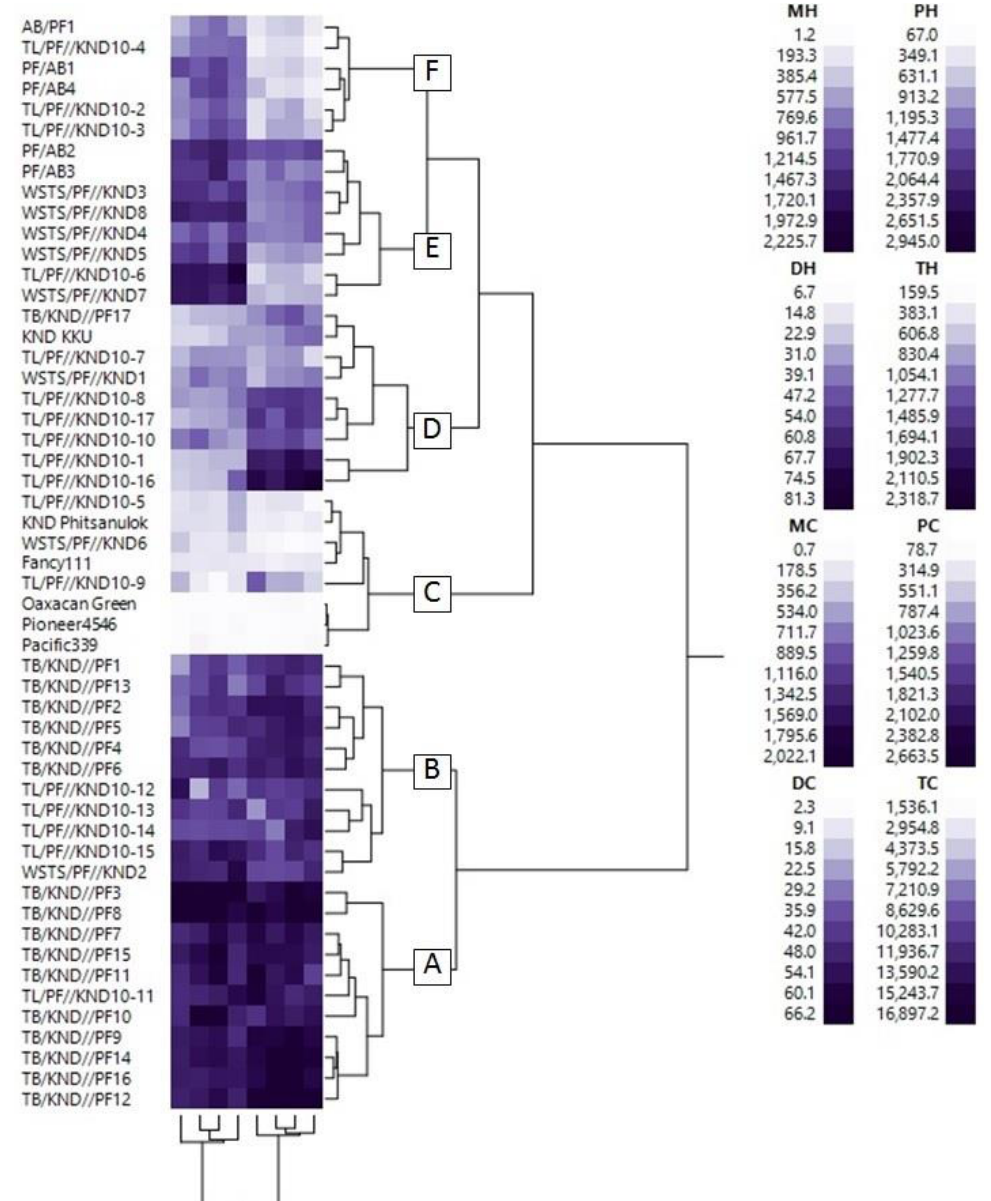
Figure 1. Dendrogram of genetic relationships among 53 genotypes. Two ways Ward’s cluster analysis based on antioxidants and antioxidant activities traits. Six main clusters (A to F) were formed, MH monomeric anthocyanin content on husk, MC monomeric anthocyanin content on cob, PH total phenolic content on husk, PC total phenolic content on cob, DH 2,2-diphenyl-1-picrylhydrazyl radical scavenging ability on husk, DC 2,2-diphenyl-1-picrylhydrazyl radical scavenging ability in cob, TH Trolox equivalent antioxidant capacity in husk, TC Trolox equivalent antioxidant capacity on cob.